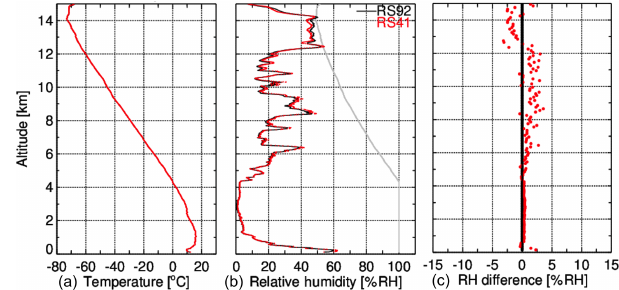
Figure 9. Twin sounding with RS92 and RS41 on the same balloon performed on 2 November 2015, 12:00UTC, at Lindenberg Me- teorological Observatory. (a) The observed temperature profile of RS92 (black) and RS41 (red). (b) The observed relative humidity profile over water; the grey trace represents ice saturation. (c) The differences between the humidity of the two sondes (RH41–RH92); the red dots represent data collected in 500m altitude